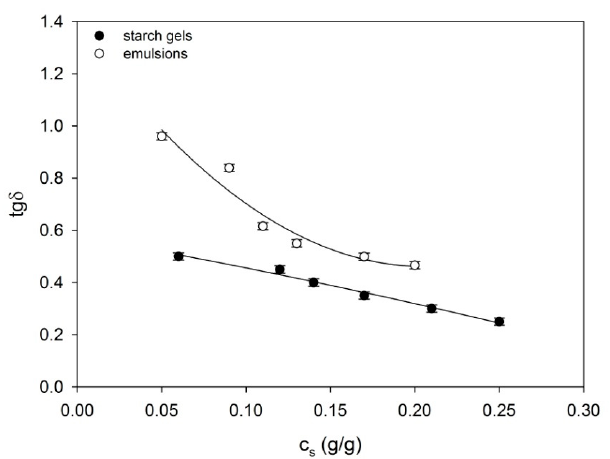
Figure 4. The tg δ in the process of formation of the examined starch gels and starch–fat emulsions. The values are expressed as means ± SD ( n = 3).